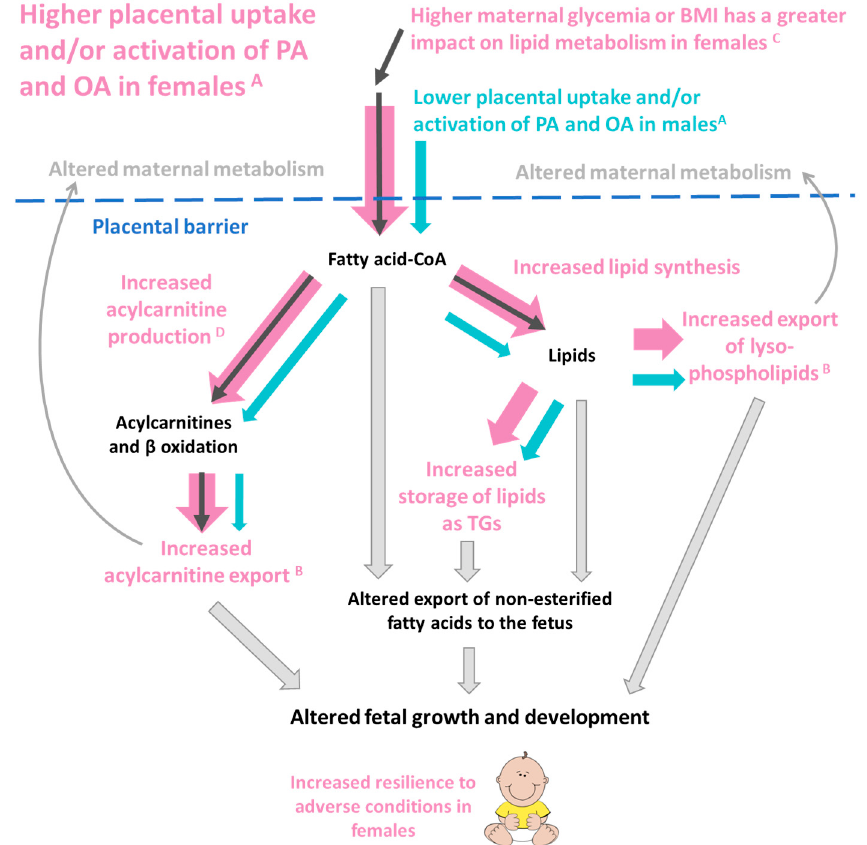
Figure 9. A postulation of how the sex-dependent placental metabolism of palmitic acid (PA) and oleic acid (OA) may influence offspring outcomes. A Female placenta produce more OA and PA labeled lipids from every measured lipid class, suggesting a greater capacity for fatty acid uptake and activation. B Female placenta also export a higher proportion of lysophospholipids and acylcarnitines compared to males. C In females, but not males, increases in maternal glycemia or BMI are associated with increases in placental PA and OA acylcarnitines and increases in PA lipids generally. In females, increased PA and OA acylcarnitines D are associated with increased birthweight. Thus, increased placental fatty acid uptake and incorporation in females (represented by the fatter pink arrows) could influence placental lipid reservoirs, local placental lipid activity, maternal–fetal lipid transfer and placental signaling to both fetus and mother. Placental lipid processing could influence maternal and fetal metabolism through both direct and indirect lipid-mediated pathways and hence impact fetal development.